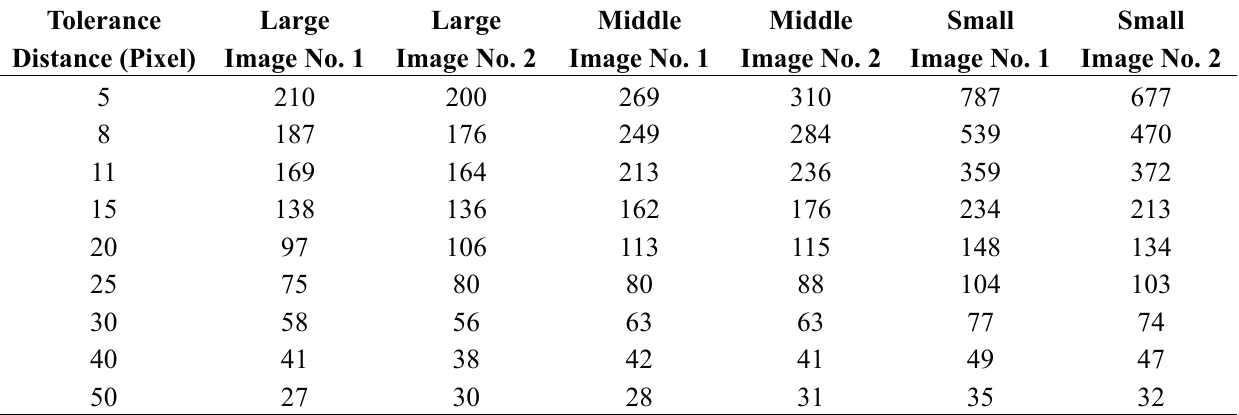
Figure 9. Corner point numbers (white spot numbers) distribution. ( a ) Corner point number distribution from Table 1; ( b ) Corner point number distribution of 30 different types of bubble images. Table 1. Classification analysis based on the number of corner points (threshold of corner point detection algorithm is